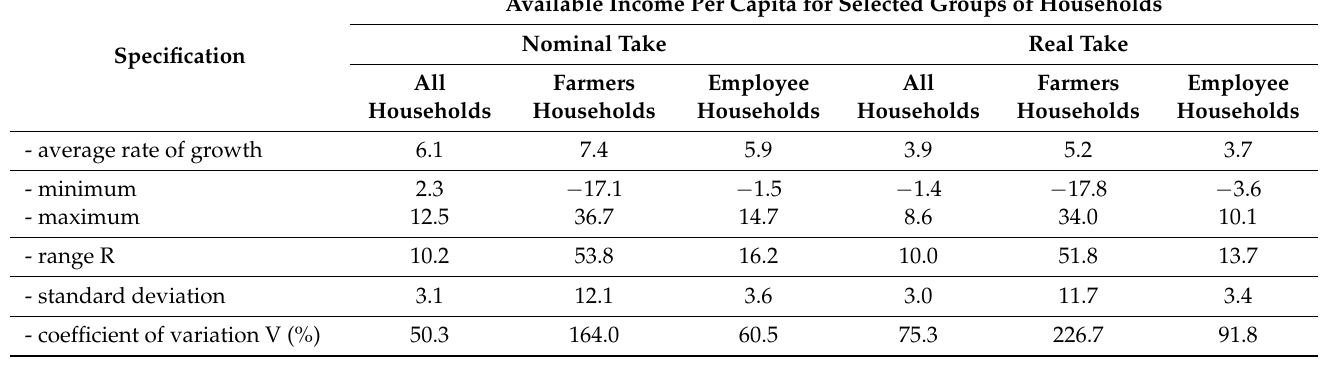
Table 2. Changes (in %) of the annual growth rates of real income of farmers ‘households against the background of total households and employees’ households in 2003–2020.